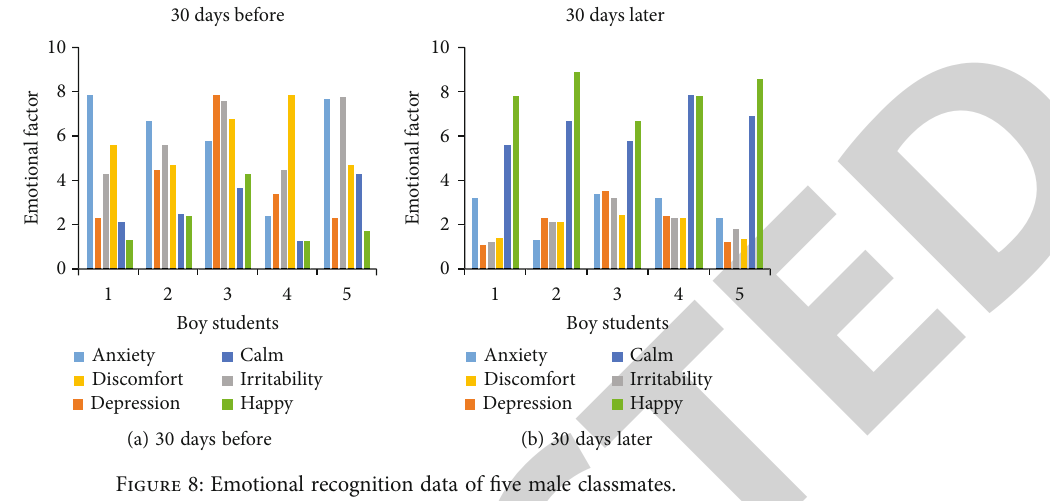
Figure 8: Emotional recognition data of fi ve male classmates.